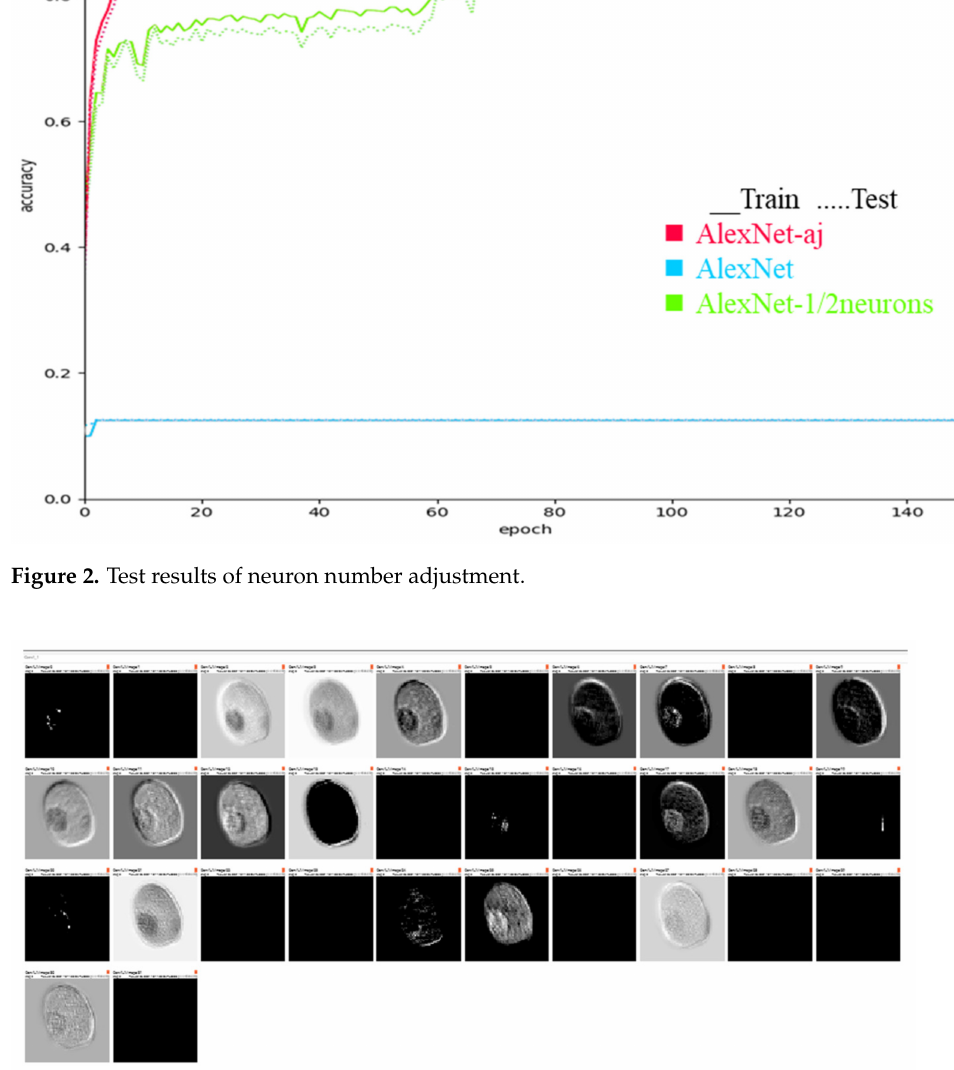
Figure 3. Convolution visualization results of AlexNet for Convolutional Layer